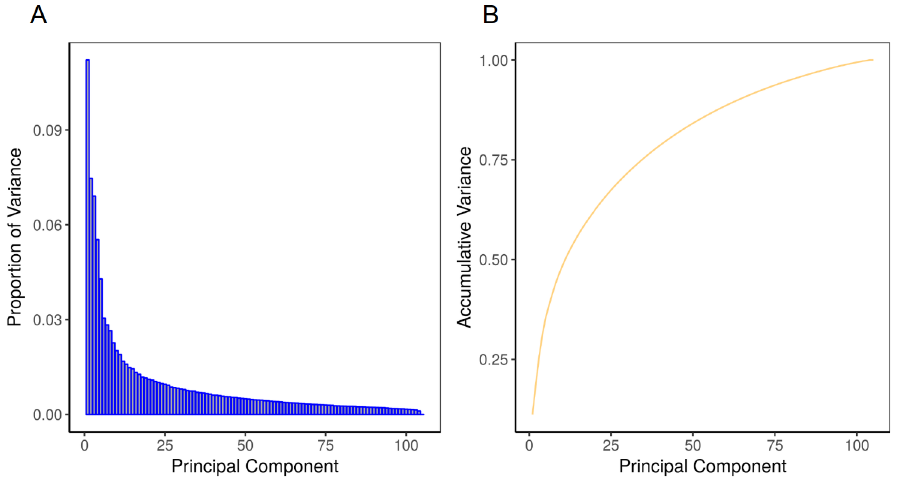
Fig 3. (A) Proportionof variance and (B) cumulativevarianceof principalcomponentsfor the analysisof Dataset 1.